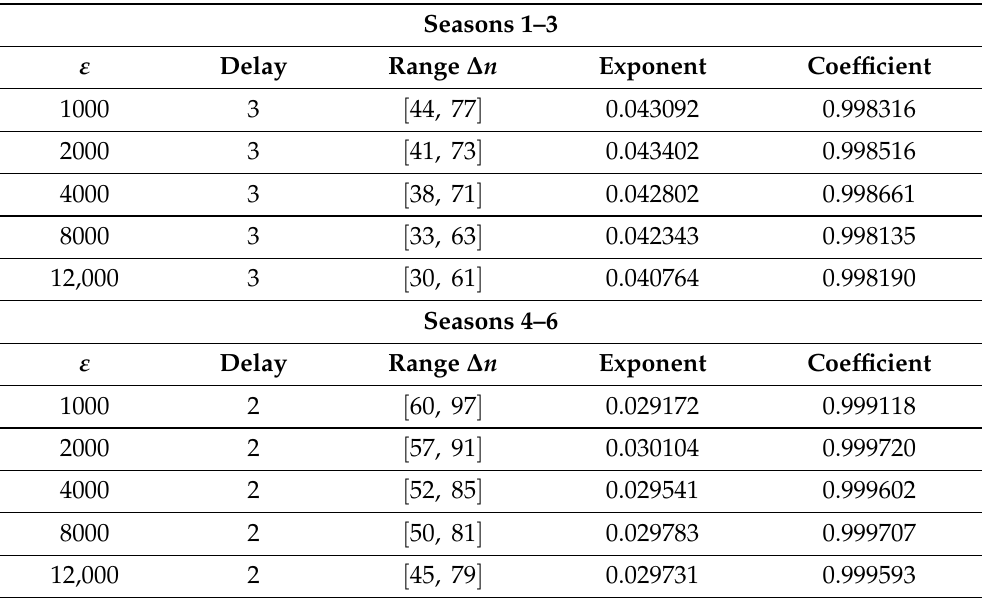
Table 7. Maximal Lyapunov exponents for coop3 (first and second half).